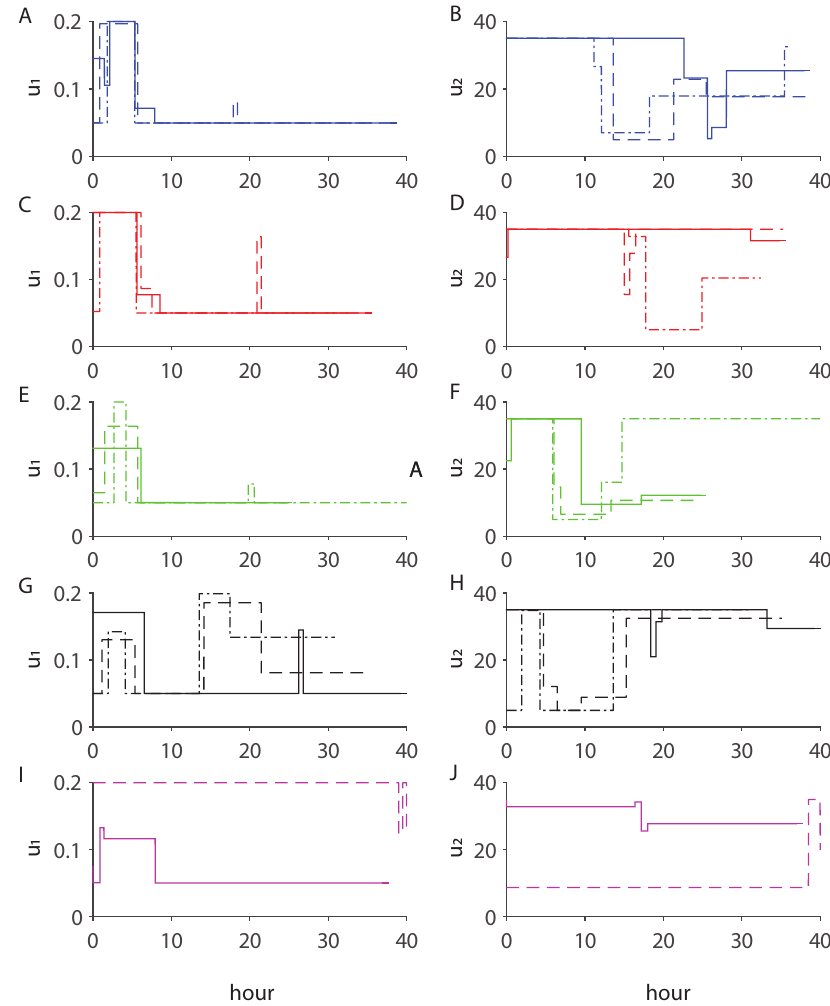
Figure 3. Optimal dilution factor and feed substrate concentration. Optimal dilution factor ( u 1 in h − 1 , left panels) and feed substrate concentration ( u 2 in g/L, right panels). ( A , B ) D-optimal (blue). ( C , D ) A-optimal (red). ( E , F ) E-optimal (green). ( G , H ) modified E-optimal (black). In panels ( A – H ), the optimal u 1 and u 2 using Fisher information matrix (FIM)-based criteria are shown by solid line. Those using FIM-based criteria combined with curvatures are shown by dashed line, while those using FIM-based criteria combined with parameter correlation are drawn with dashed-dot line. ( I – J ) Threshold curvature (magenta, solid line), and Q-optimal design (magenta, dashed